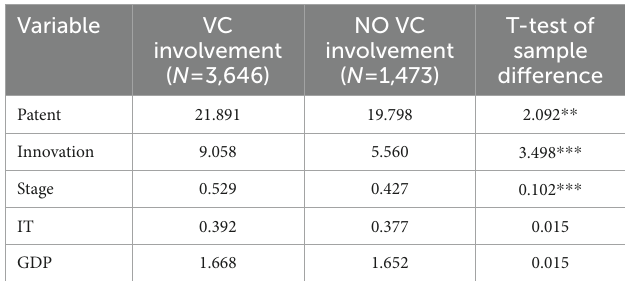
TABLE 2 Mean test.